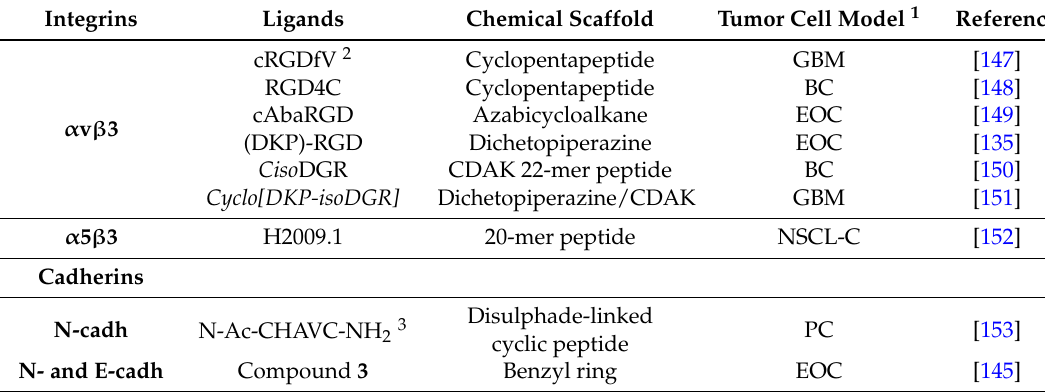
Table 1. Integrins or cadherins expressed on EOC cells and their suitable